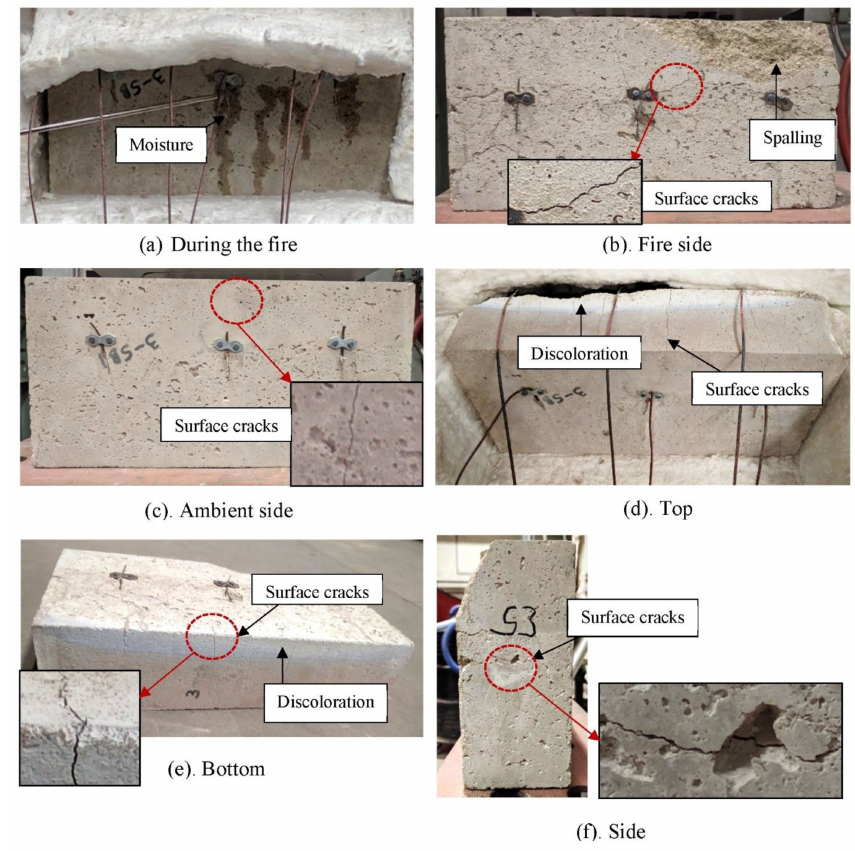
Figure 17. C-S block surfaces ( a ) during and ( b – f ) after the building fire